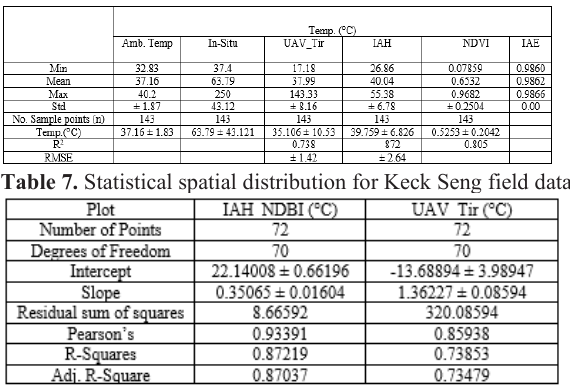
Table 8. The correlation coefficient results for in-Situ Vs